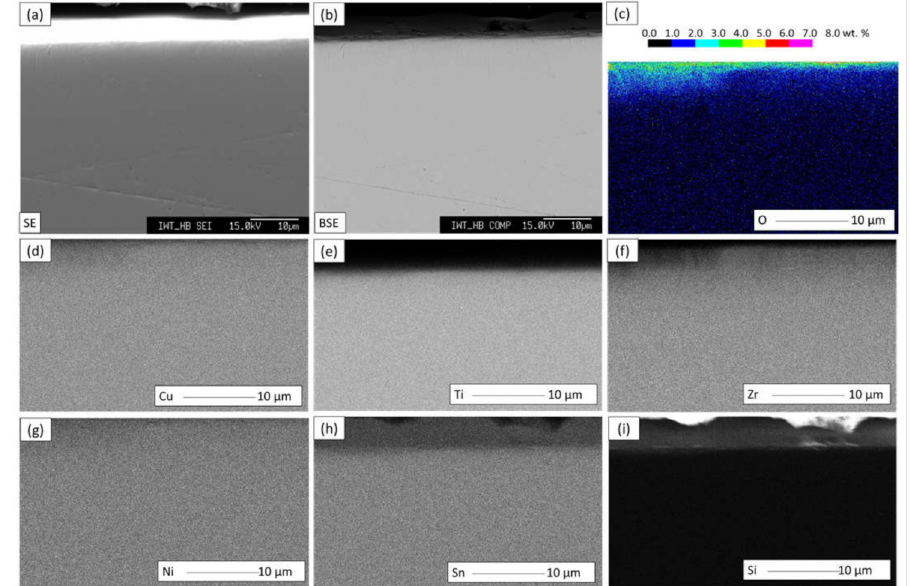
Figure 4. EMP (electron microprobe) results of the cast sample after the corrosion investigation including: ( a ) SE (secondary electron micrograph); ( b ) BSE (backscattered electron) micrograph; and the elemental mapping distribution of ( c ) O, ( d ) Cu, ( e ) Ti, ( f ) Zr, ( g ) Ni, ( h ) Sn, and ( i )